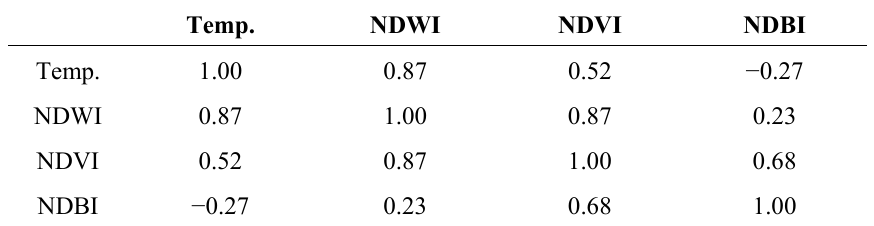
Table 3. Correlation matrix of the mean values from the indices and LST in a bare cover pattern. Temp. NDWI NDVI NDBI Temp. 1.00 0.87